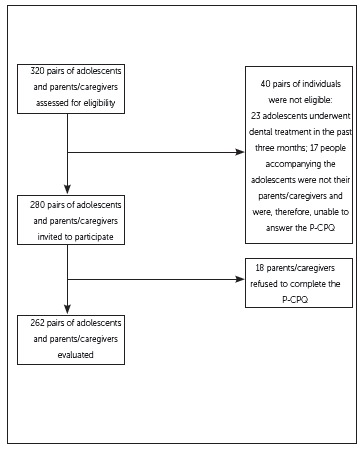
Flow diagram of the study.